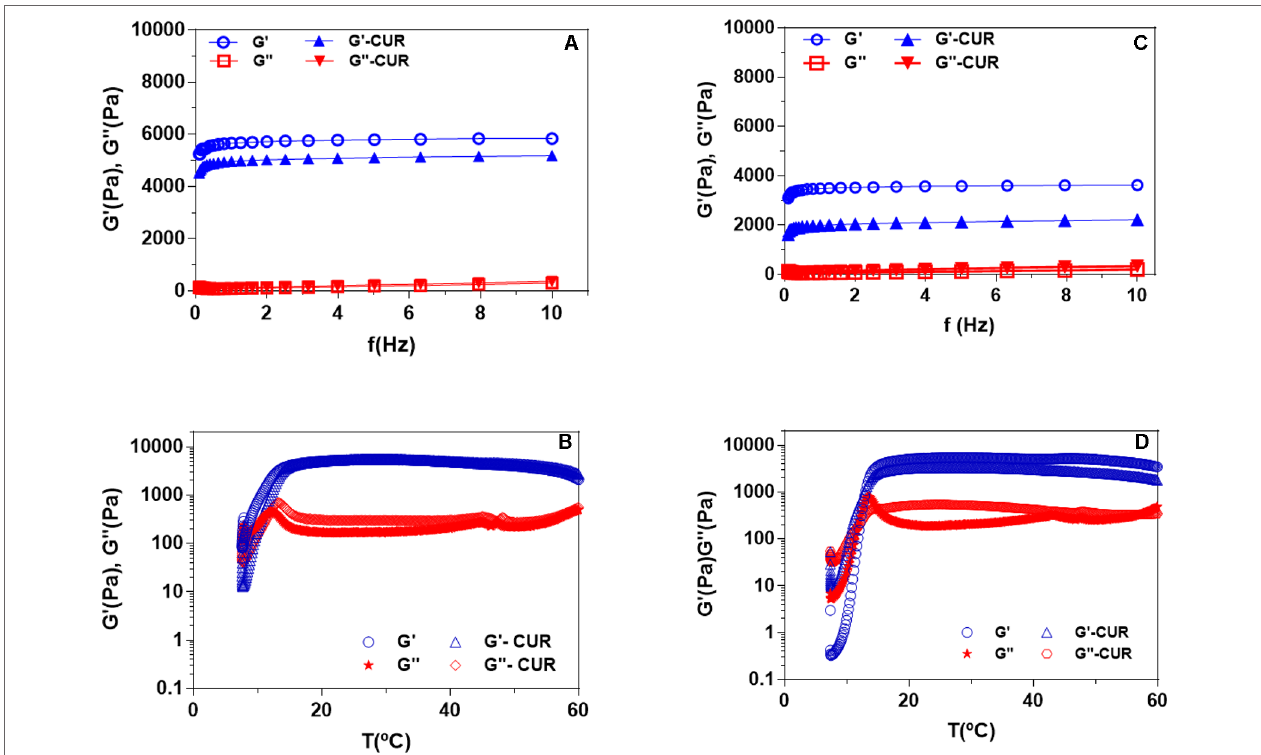
FIGURE 3 | Rheograms display the frequency sweep (A, C) and sol–gel transition (B, D) analysis for organogels composed of OA-F-127 (A, B) OA-F-127/L-81 (C, D)